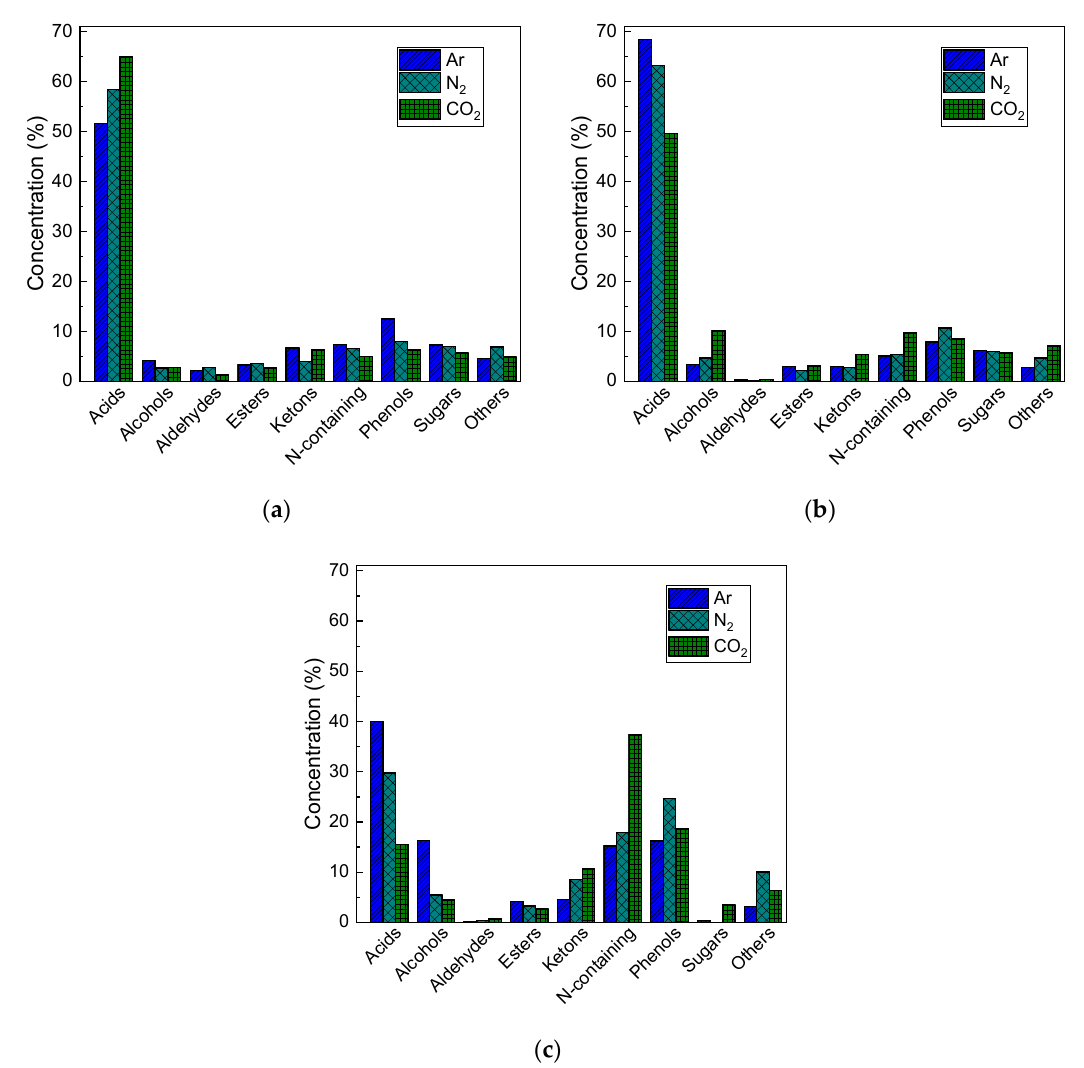
Figure 5. Relative content of different groups of chemicals in organic fraction of oil received under argon, nitrogen, and carbon dioxide at ( a ) 500 °C, ( b ) 600°C, and ( c ) 700 °C.